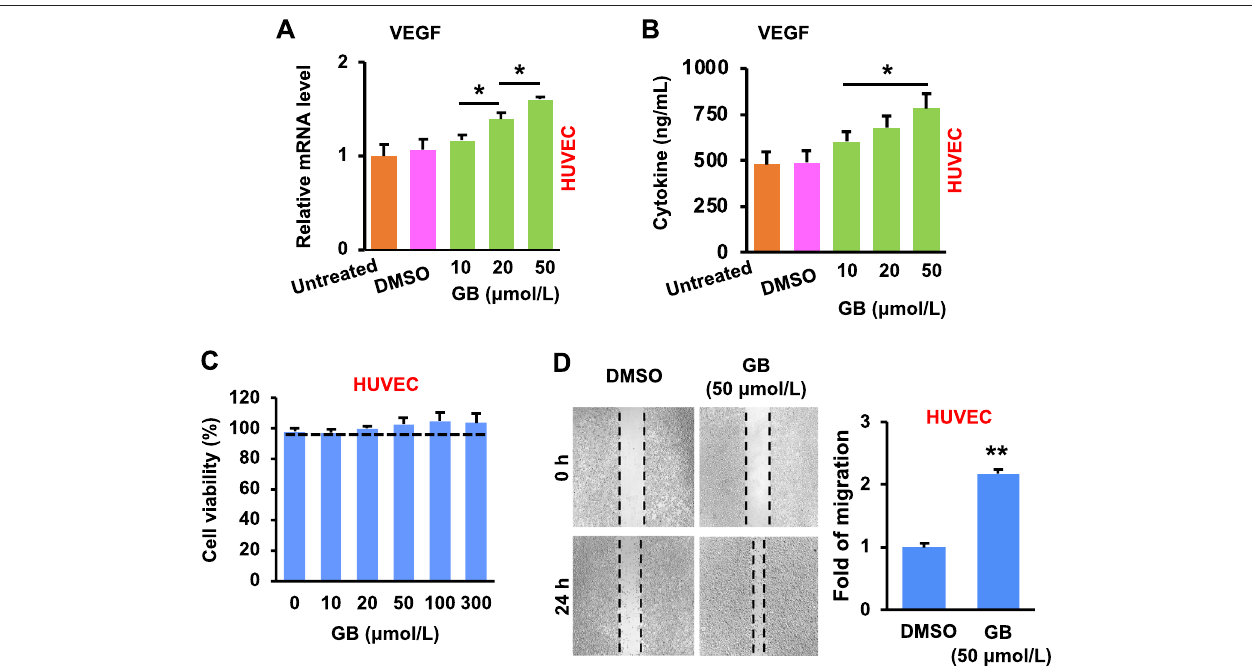
FIGURE3| GBpromotes invitro proliferativeactivityofendothelialcells. (A) ThelevelofVEGFmRNAinHUVECfollowingGBtreatment(10,20,and50 μ mol/L)( n = 3; * p < 0.05). (B) The release of VEGF protein in the culture supernatant of HUVEC following GB treatment (10, 20, and 50 μ mol/L) ( n = 3; * p < 0.05). (C) Cytotoxicity of HUVEC after the treatment of GB (10, 20, 50, 100, and 300 μ mol/L). (D) The empty places before and after treatment of GB (50 μ mol/L) were measured for the fold of migration ( n = 3; ** p < 0.01).